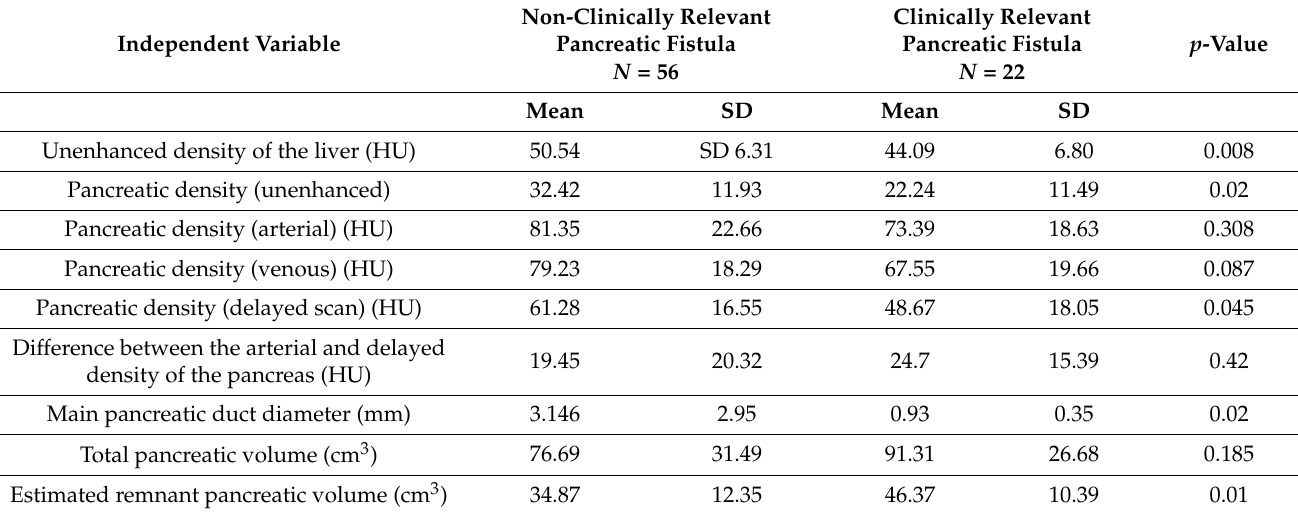
Table 2. Univariate analysis of the independent factors and their association with clinically relevant pancreatic fistula